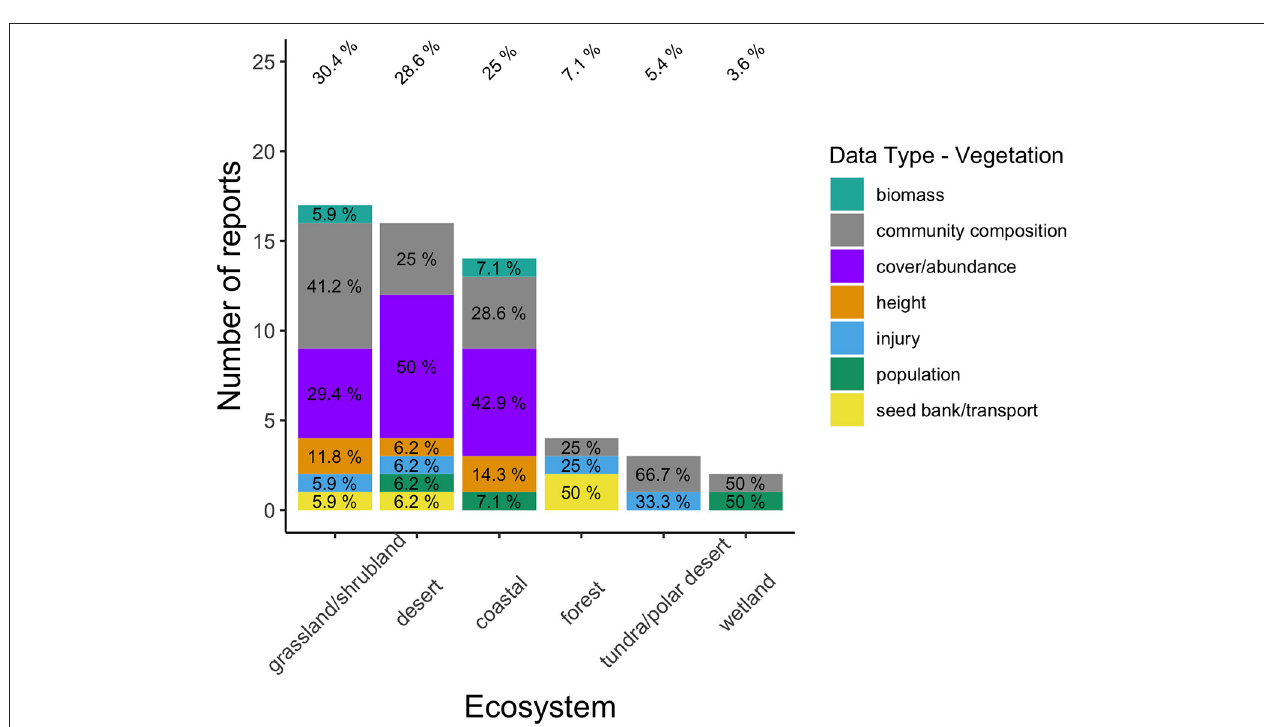
in tundra/polar desert habitats ( n = 4; Figure 5 ) measured community composition ( n = 2) and injury to shrubs, grasses, and sedges ( n = 1). In wetland habitats ( n = 2),